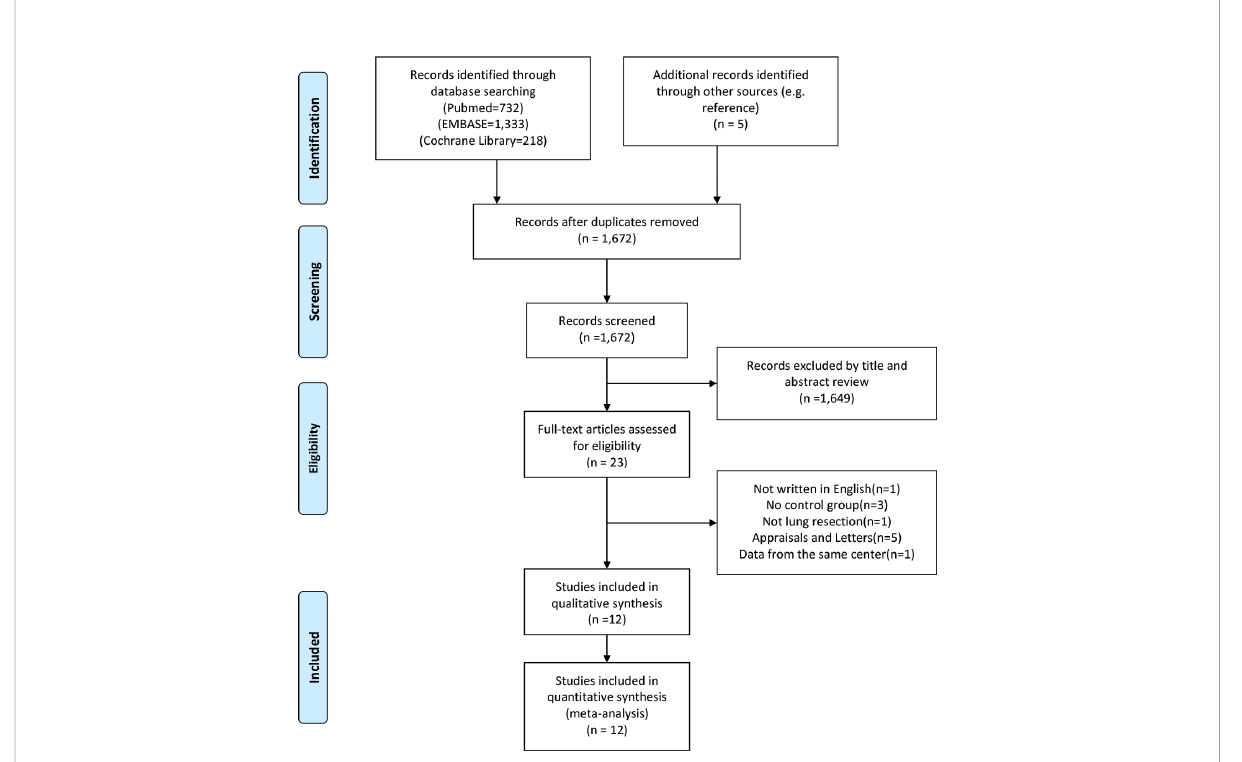
FIGURE 1 PRISMA fl ow diagram of literature retrieval. PRISMA, Preferred Reporting Items for Systematic Reviews and